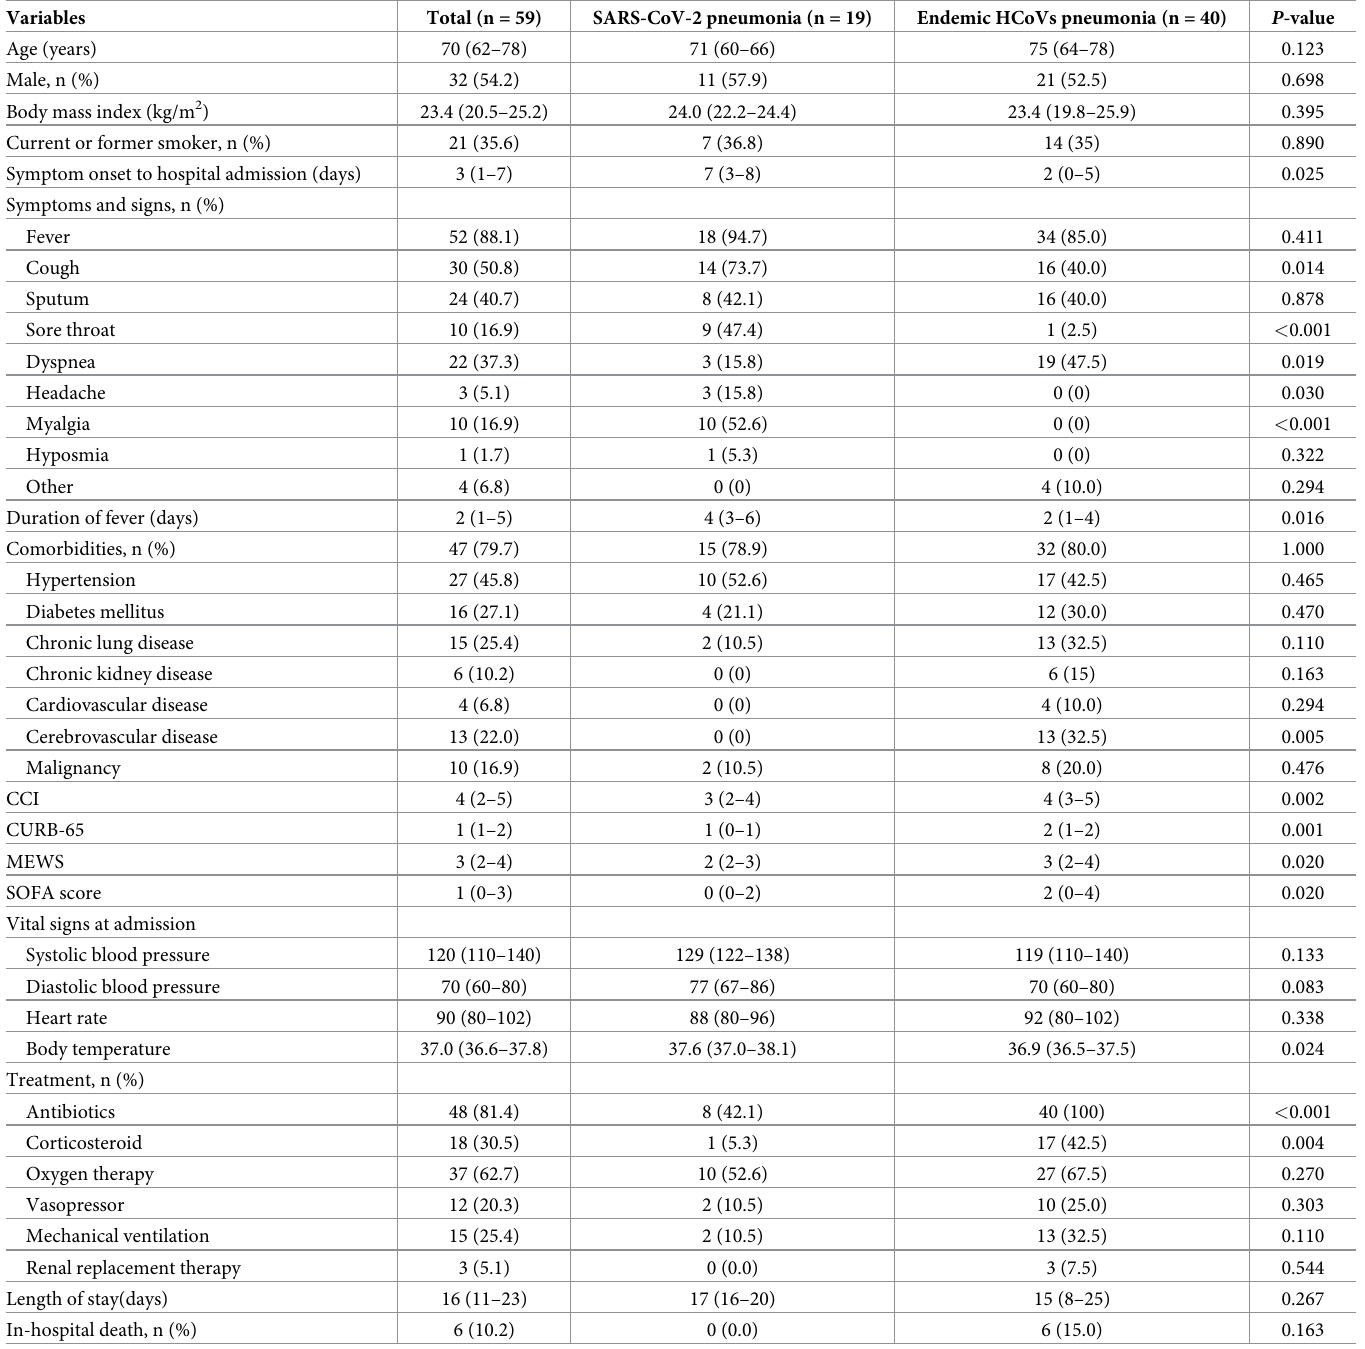
Table 1. Baseline characteristics of the